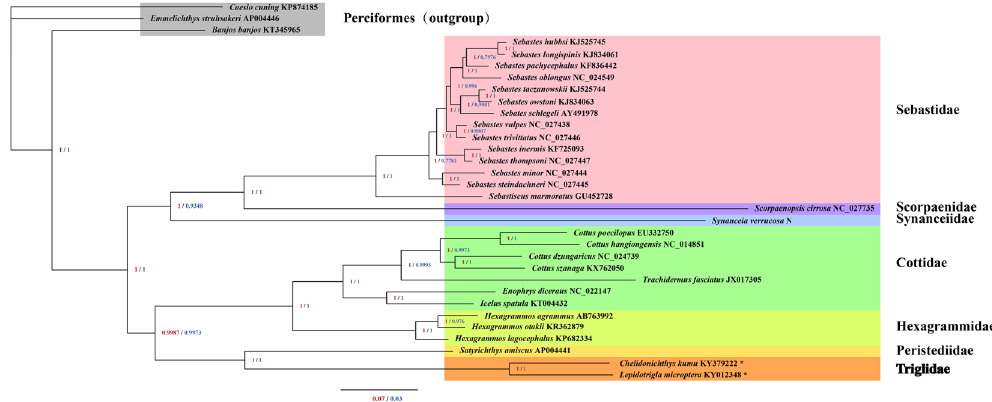
Figure 7. Phylogenetic trees inferred from amino acid and nucleotide sequences of 13 PCGs of the mitogenome using BI analysis. Perciformes fish ( C. cuning , E. struhsakeri and B. banjos ) were used as outgroups. The numbers along branches indicate posterior probability values (red for amino acid and blue for nucleotide sequences). The accession numbers are shown behind the species